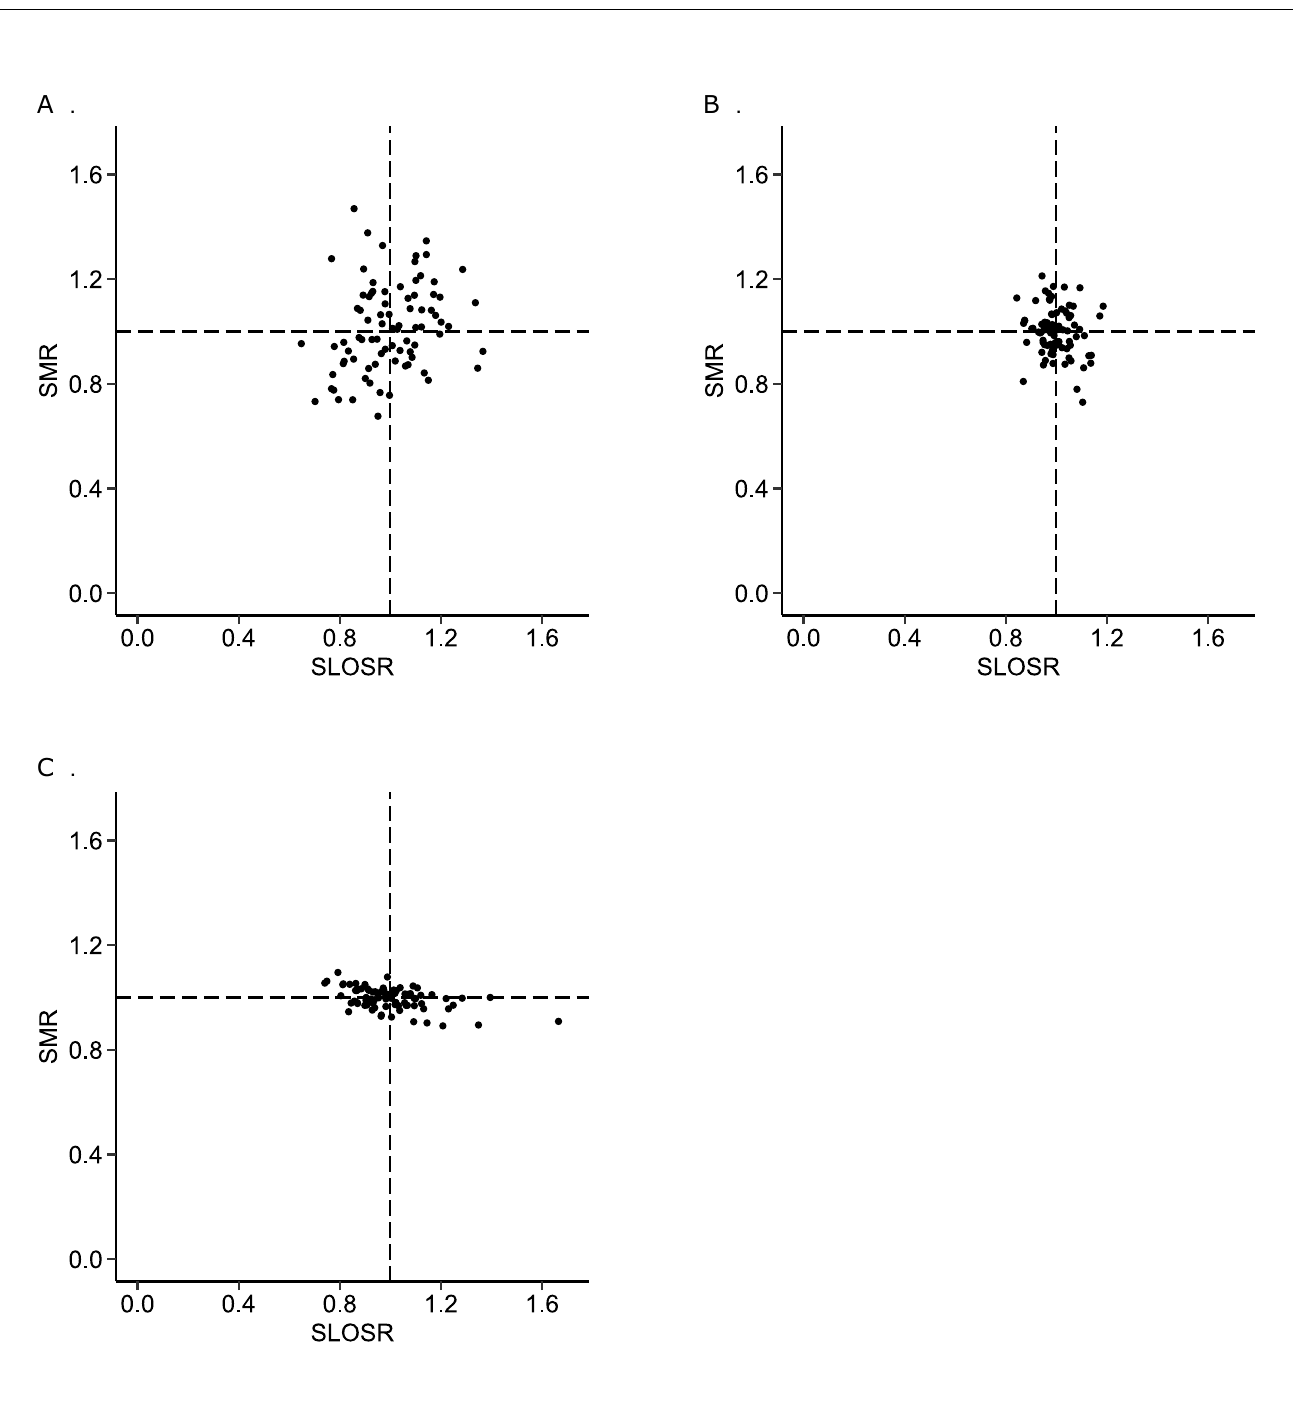
Fig 3. Quality indicators SMR and SLOSR plotted against each other on ICU level for patients grouped based on severity of illness defined using the probability of mortality. Fig 3A: probability of mortality smaller than 0.3. Fig 3B: probability of mortality larger or equal to 0.3 and smaller than 0.7. Fig 3C: probability of mortality larger or equal to